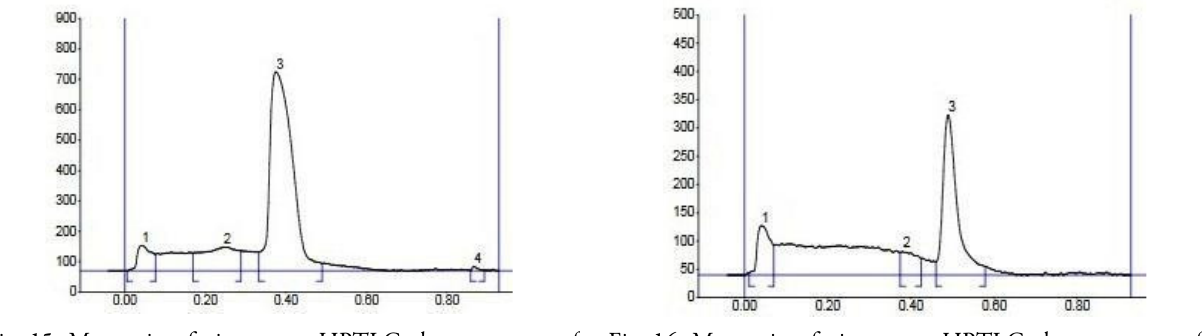
Fig. 16. Maceration fruit extract, HPTLC chromatogram of methanolic fruit extract of M. cymbalaria